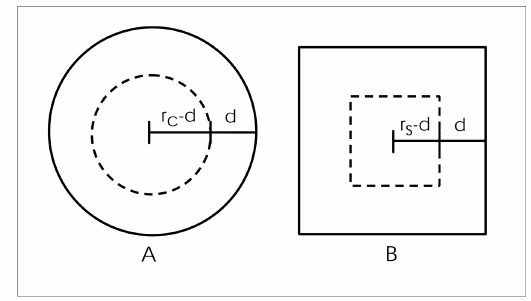
Fig. 3. The necessity of a reference value for a with radius equal to r with radius equal to r are bounded by a dashed line. A larger area of shape B is needed to observe an equal a